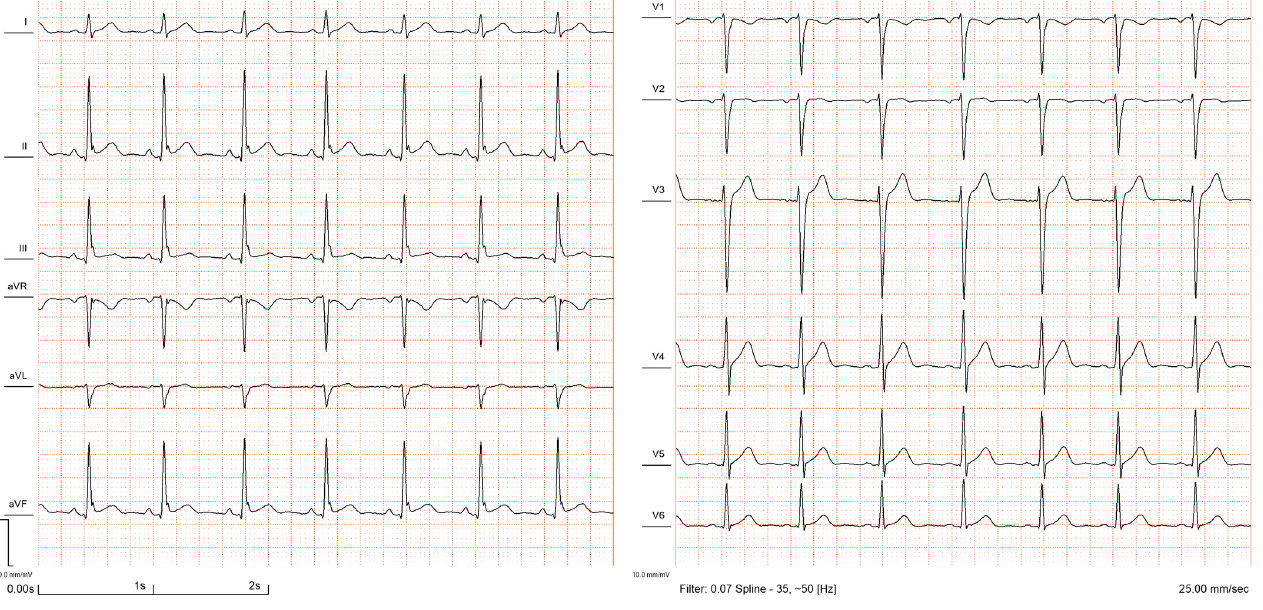
Figure 2. ECG registration with ERP with notching morphology in the inferior leads. The ECG is from the authors’ personal collection.